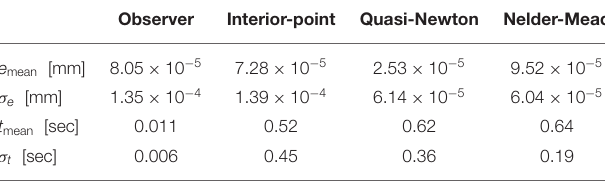
TABLE 3 | Experimental results. Observer Interior-point Quasi-Newton